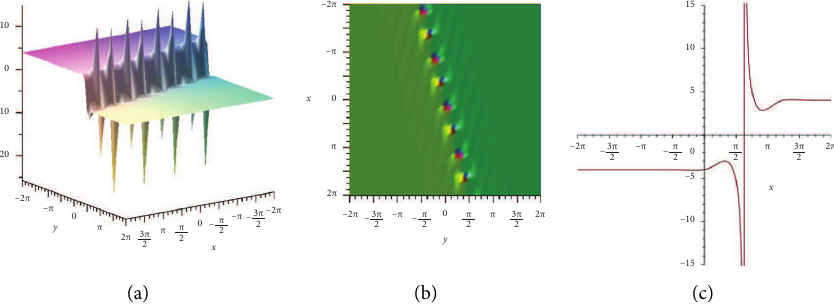
� 2 , ϵ � − 1 , p � 2 , α � − 4 , β � 4 , and k � ( 3/2 ) at time t � 0. (a) Perspective view of 1 2